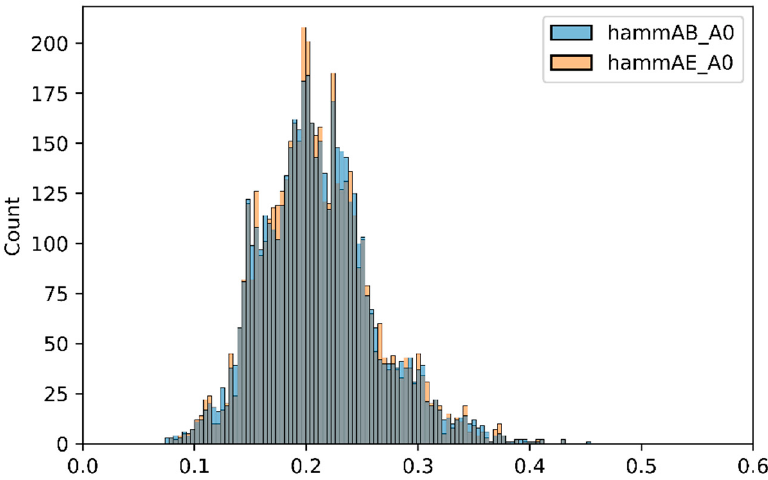
Figure 7. Histogram of normalized Hamming distances between Alice and Bob (0.2111 ± 0.0511), and Alice and Eve (0.2109 ± 0.0503), at the beginning of the algorithm. For all di ff erent (Alice, Bob) pairs, Eve is selected randomly from the rest participants.